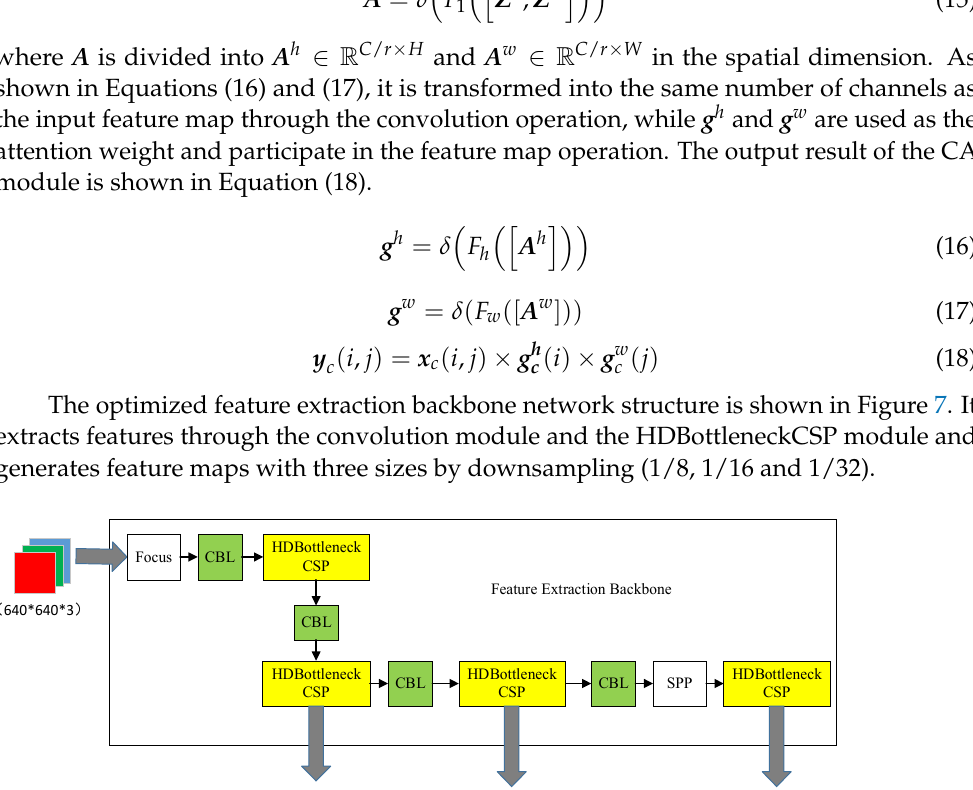
in Figure 8a. The PANet aggregates features along two paths: top-down and bottom-up.